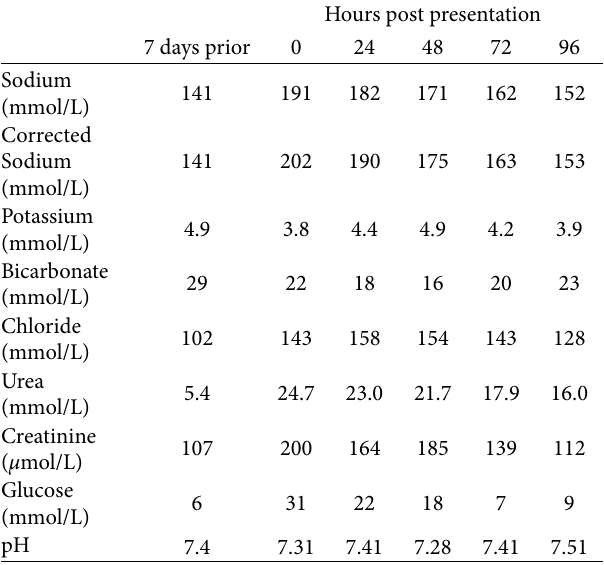
Table 1: Blood laboratory values over the initial 96